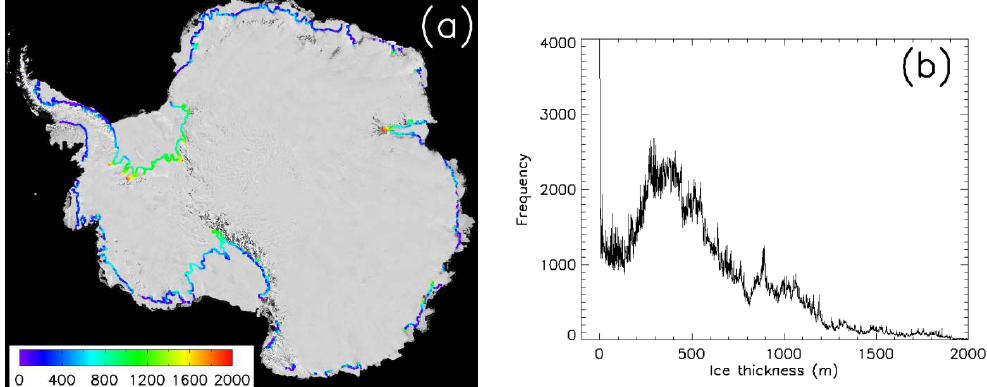
Figure 10. Ice thickness calculated along the ASAID hydrostatic line (a) mapped on the Landsat Image Mosaic of Antarctica with color representing ice ‐ equivalent thickness (cf., Equation 3 in text) and (b) presented as a histogram of values.